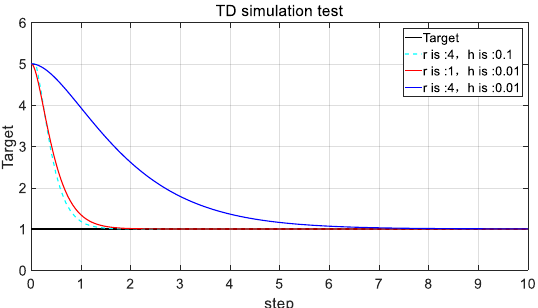
Figure 12. The fast tracking of the desired velocity.